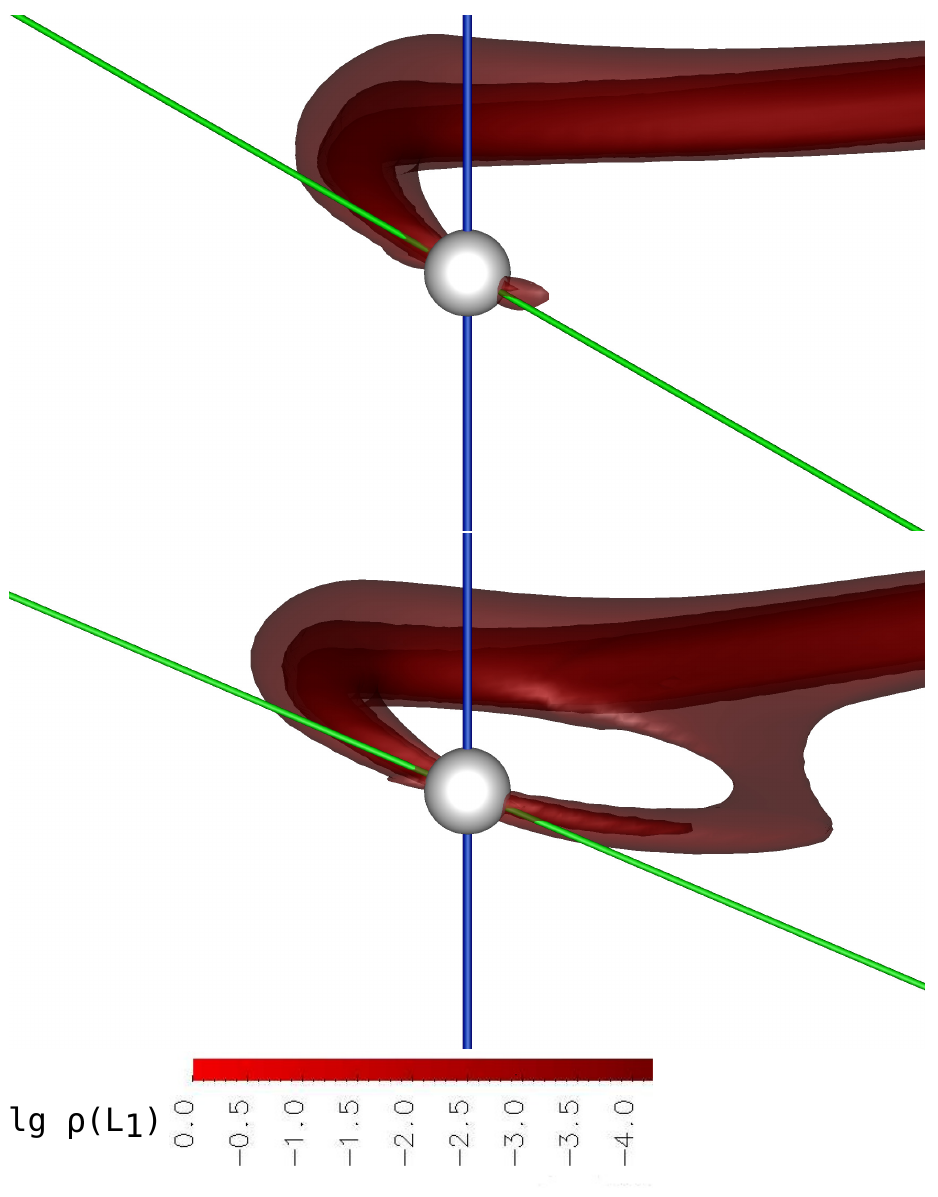
Figure 8. The result of three-dimensional numerical modeling of the structure of the flow of matter in an asynchronous polar with the non-offset dipole for the moment of switching from the north magnetic pole to the south one. The iso-surfaces of the decimal logarithm of the density are shown in units of ρ ( L 1 ) . The surface of the accretor is represented as a white sphere. The binary system is at the orbital phase 0.4. The upper panel coincides with Phase 1, and the lower panel with Phase 2 of the switching